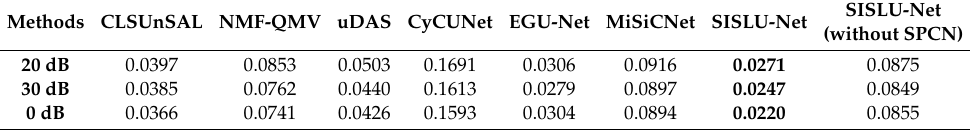
Table 4. RMSE of the Simulated Dataset. The best results are shown in